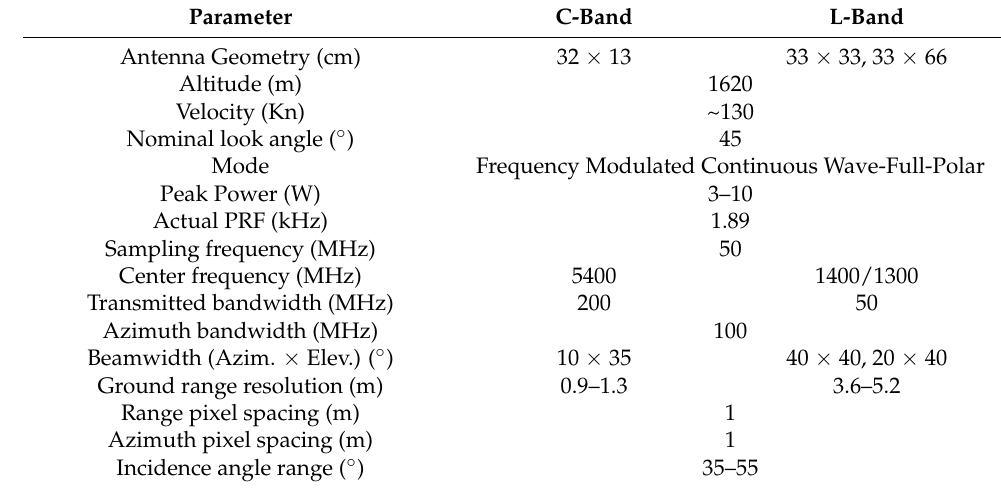
Table 2. Description of the SARSense C- and L-band radar